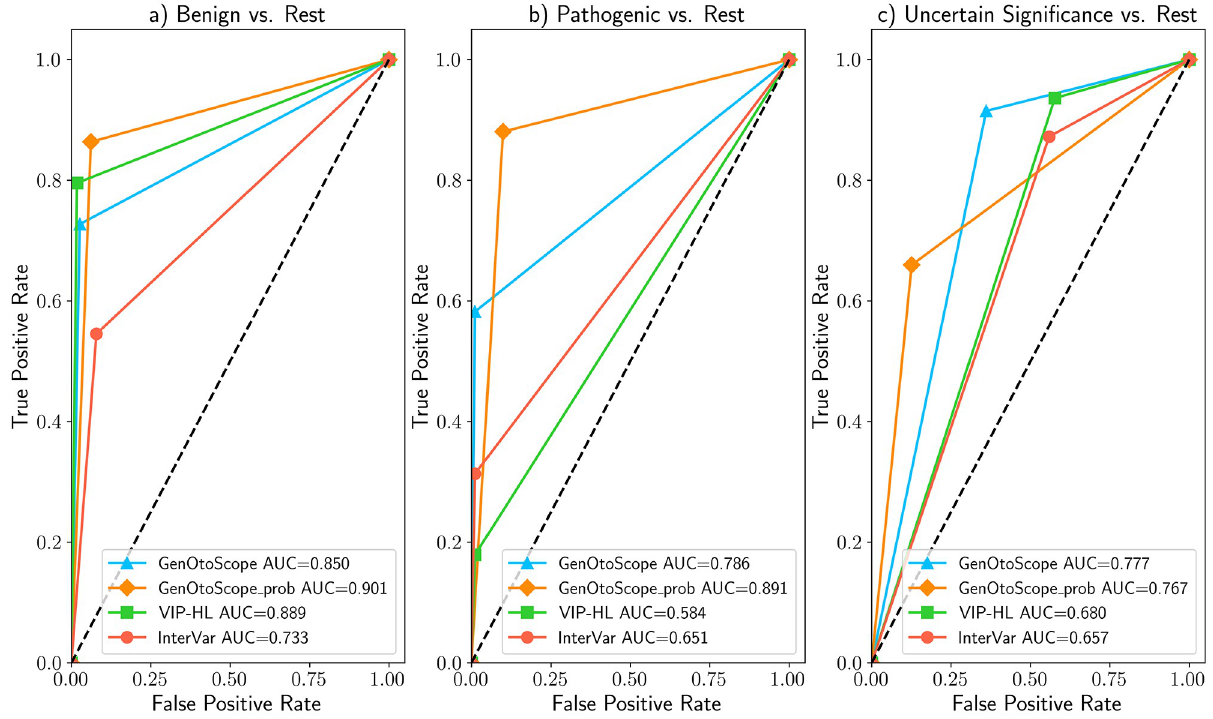
Fig 7. ROC curves and AUC scores of all classification tools for VCEP-HL data set. (A) Prediction of “Benign” broader class versus “Pathogenic” broader class and “VUS” class (B) Prediction of “Pathogenic” broader class versus “Benign” broader class and “VUS” class (C) Prediction “VUS” class versus “Benign” broader class and “Pathogenic” broader